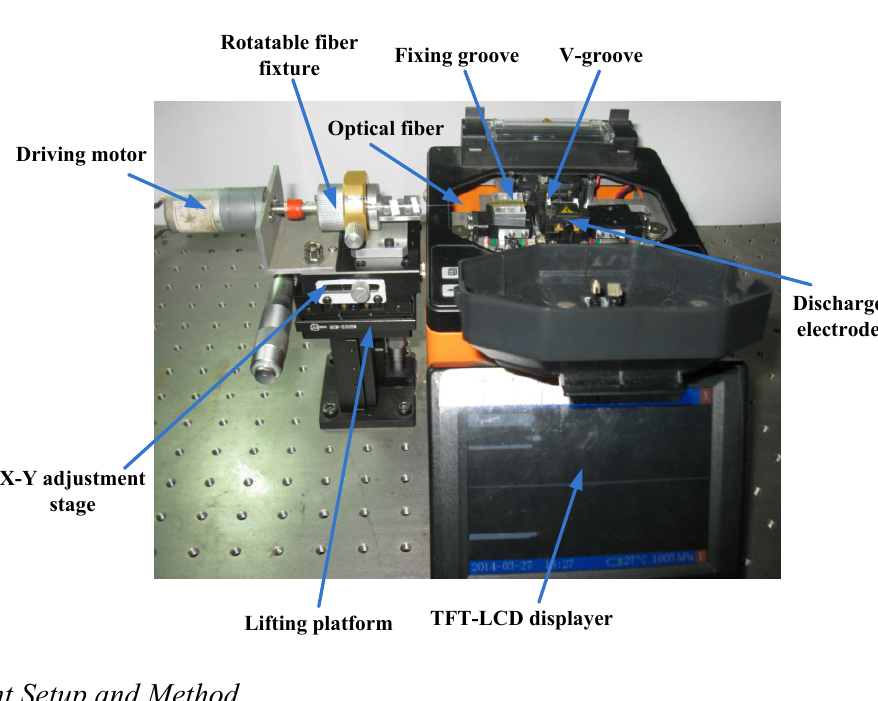
Figure 10. Structure diagram of experiment